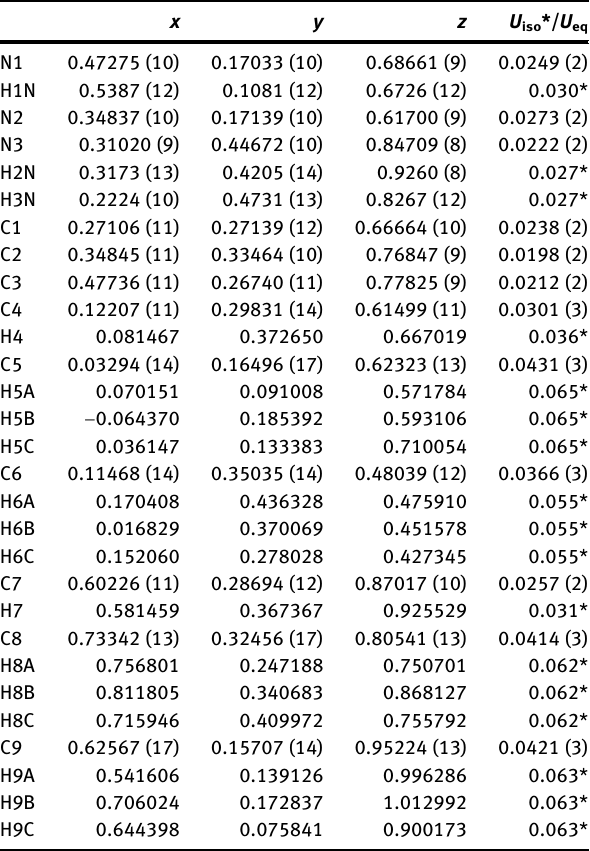
Table  : Fractional atomic coordinates and isotropic or equivalent isotropic displacement parameters (Å 